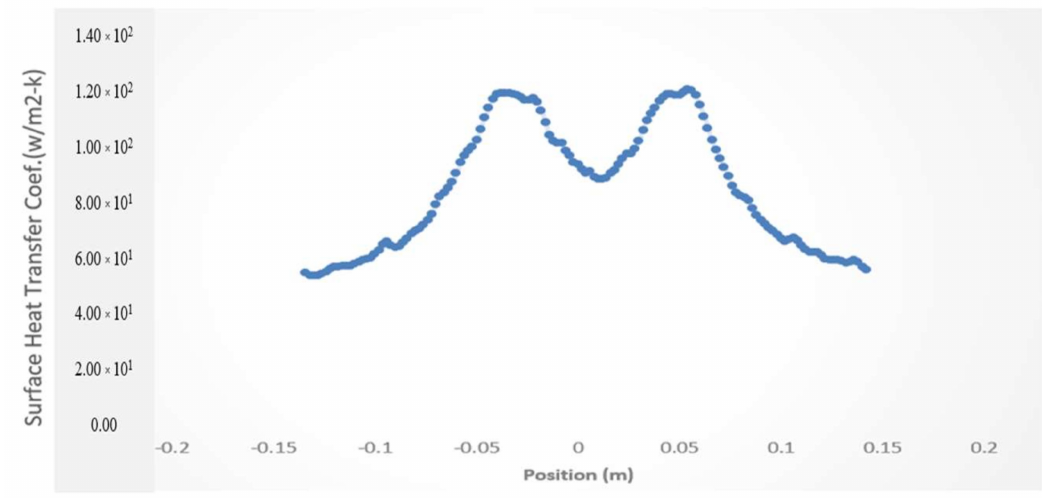
Figure 14. Heat transfer coefficient in the axial direction at Model 2.